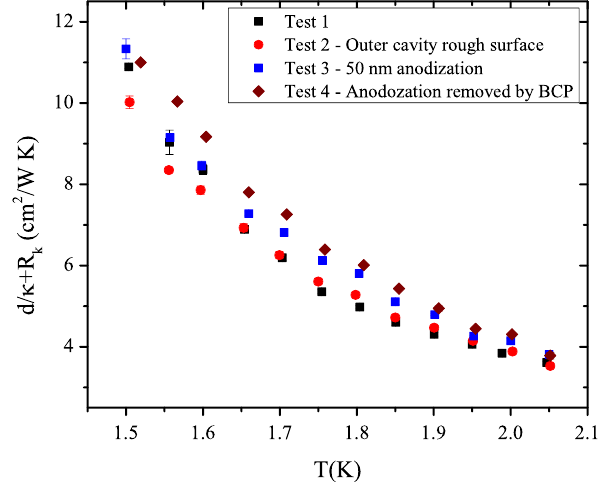
FIG. 3. Results of the thermal resistance measurement on ingot Nb cavity TD5.